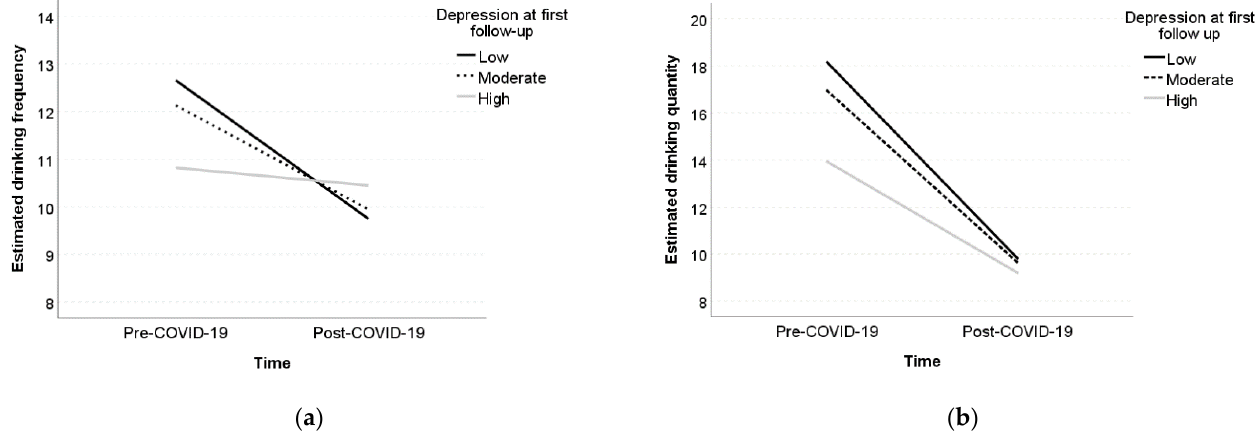
Figure 1. Simple slopes of the effect of time on drinking frequency ( a ) and drinking quantity ( b ) for selected levels of depression. Note: The depression levels correspond to the 16th, 50th, and 84th percentiles of the distribution of the depression scale describing relatively low, moderate and relatively high values of depression.